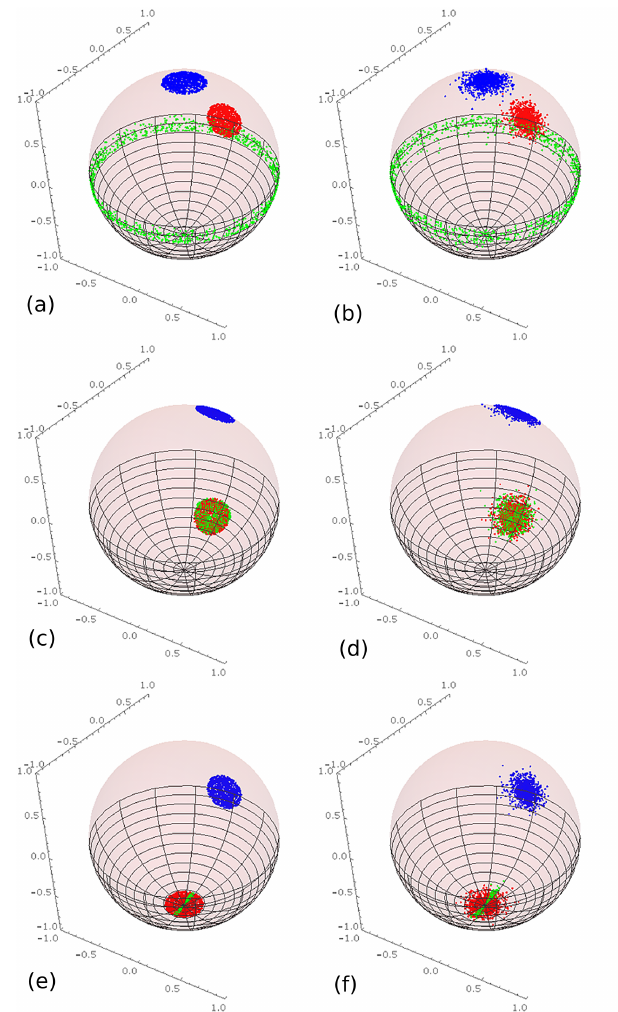
Figure 7. Effect of sampling over dip vectors or pole vectors on bounded uniform spherical distribution at a range = 10 ◦ (a, c, e) and von Mises–Fisher distribution at κ = 100.0 (b, d, f) for uncertain horizontal planes (a, b) , 45 ◦ dip planes (c, d) and vertical planes (e, f) . Correct (pole perturbed) dip vectors are green, incorrect (dip perturbed) dip vectors are red and blue vectors are the poles. See Sect. 4.1 for